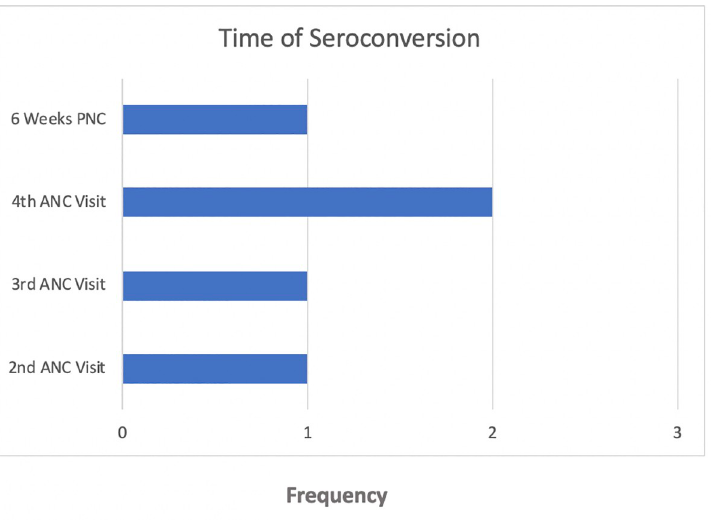
Fig 2. Time of seroconversion among